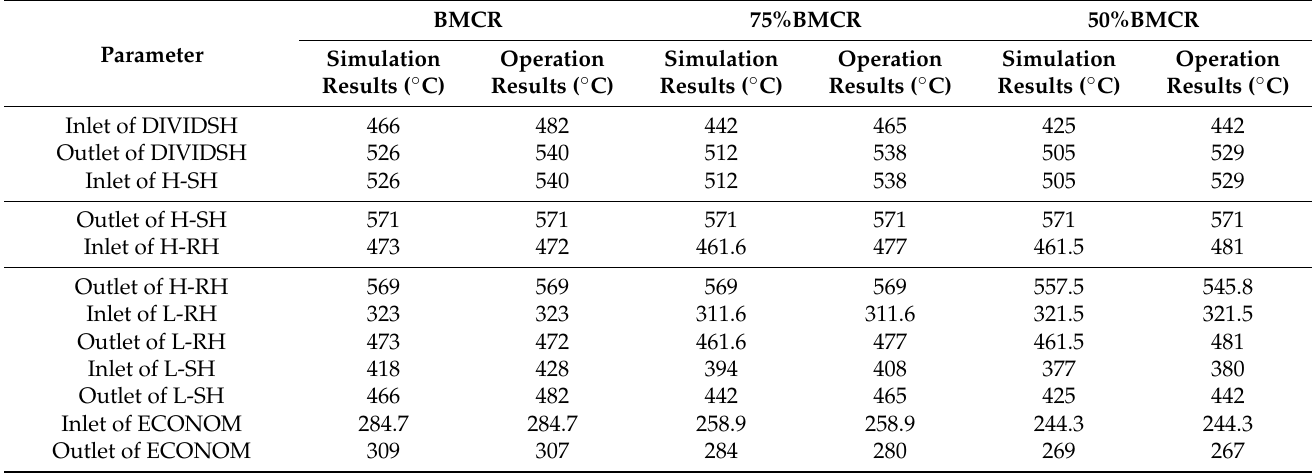
Table 6. Comparison table of working fluid simulation calculation